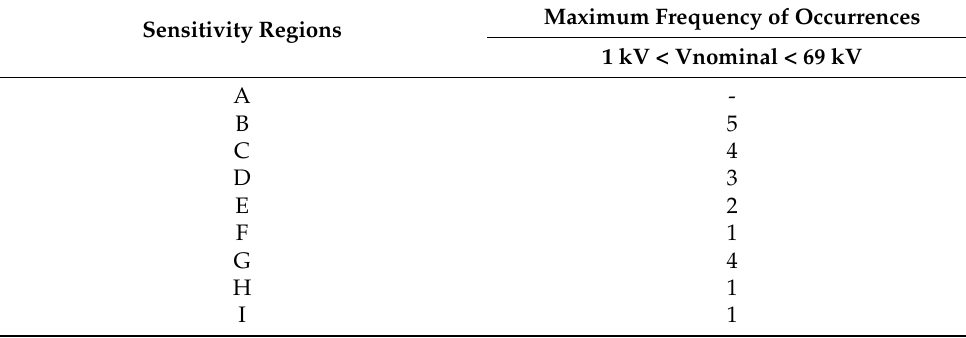
Table 2. Monthly maximum frequency of occurrence in the sensitivity regions [6].